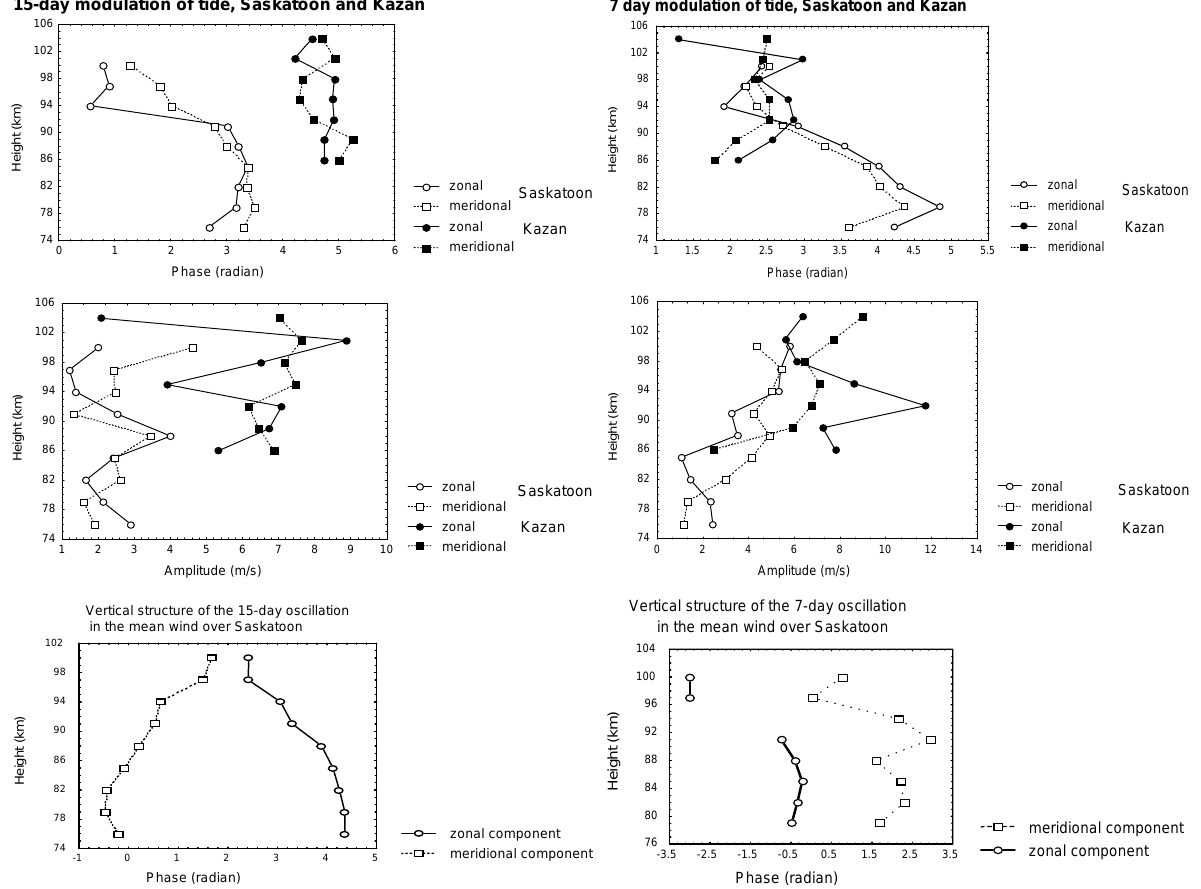
Fig. 3. Vertical profiles of the (a) 15-day and (b) 7-day modulations. The time interval used for calculation is centred at 31